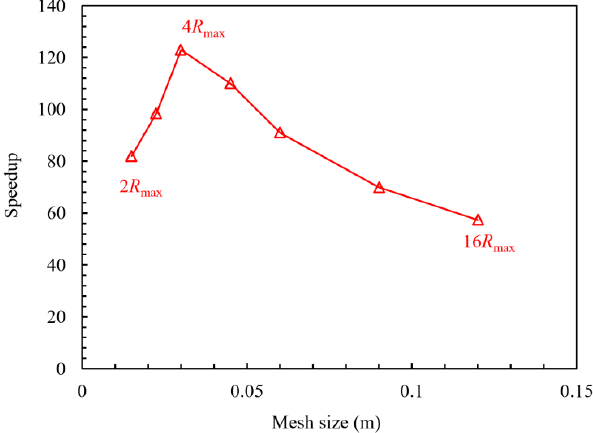
Figure 8. Influence factors on acceleration effect.